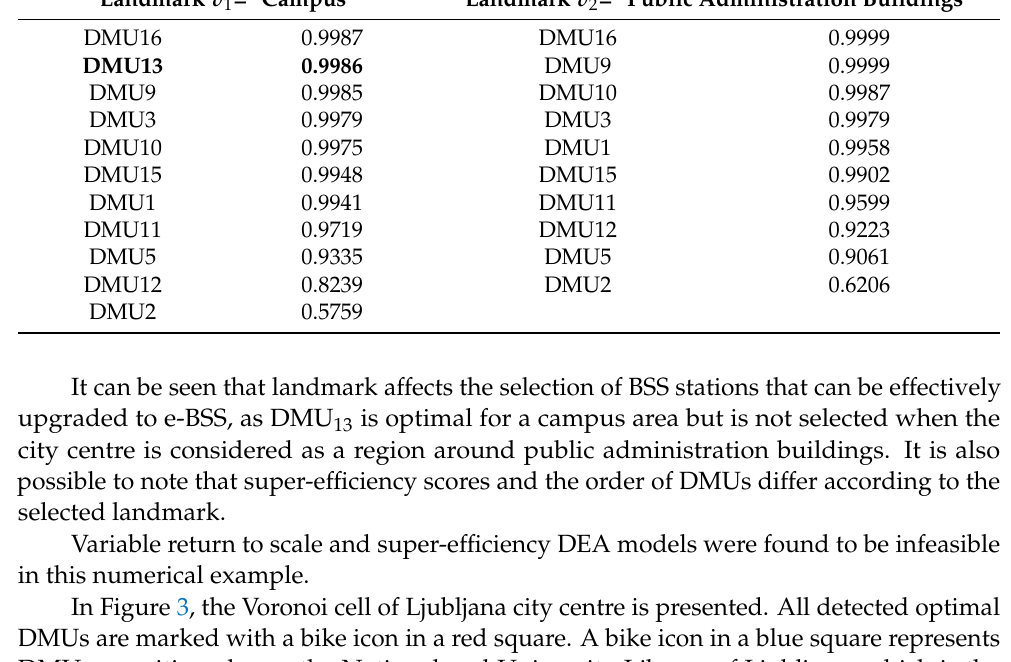
Table 2. DEA super-efficiency scores of optimal DMUs.